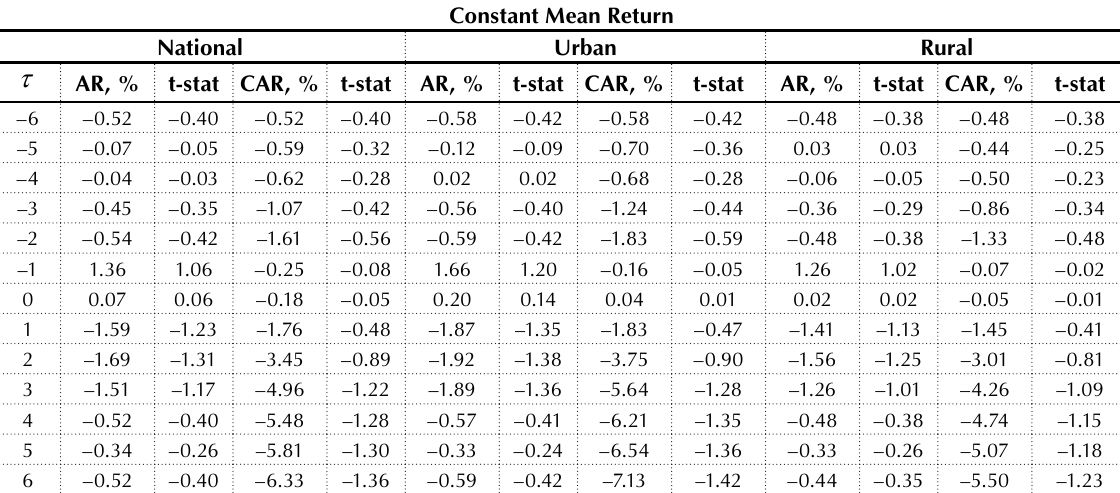
Table 4. Effect of the modification to corporate income tax law on housing